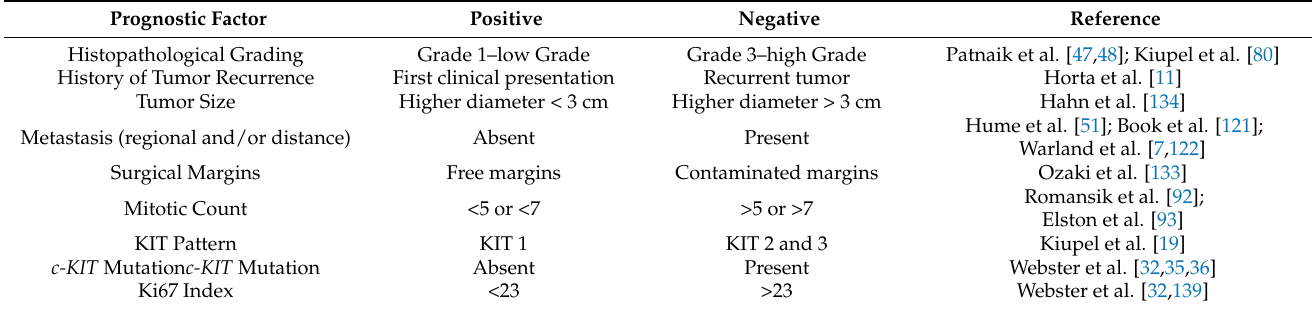
Table 4. Prognostic Factors Associated with Canine Cutaneous